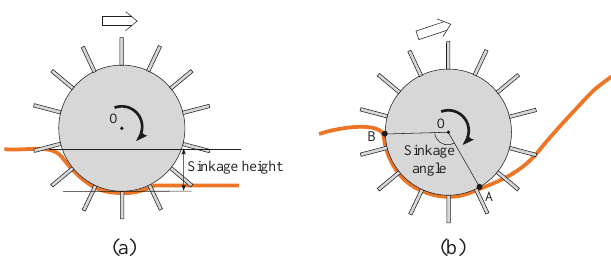
Figure 8. Measuring the amount of sinkage: ( a ) Sinkage height; ( b ) Sinkage angle.